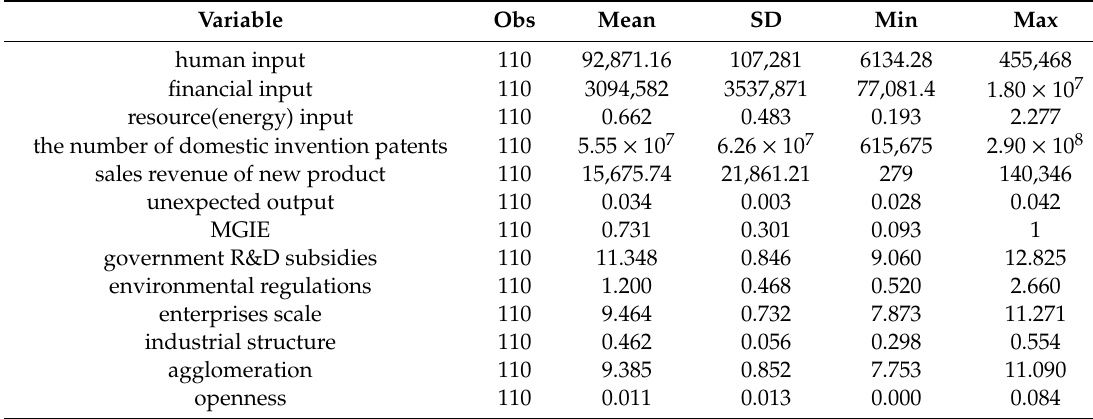
Table 2. Descriptive statistics of variables.